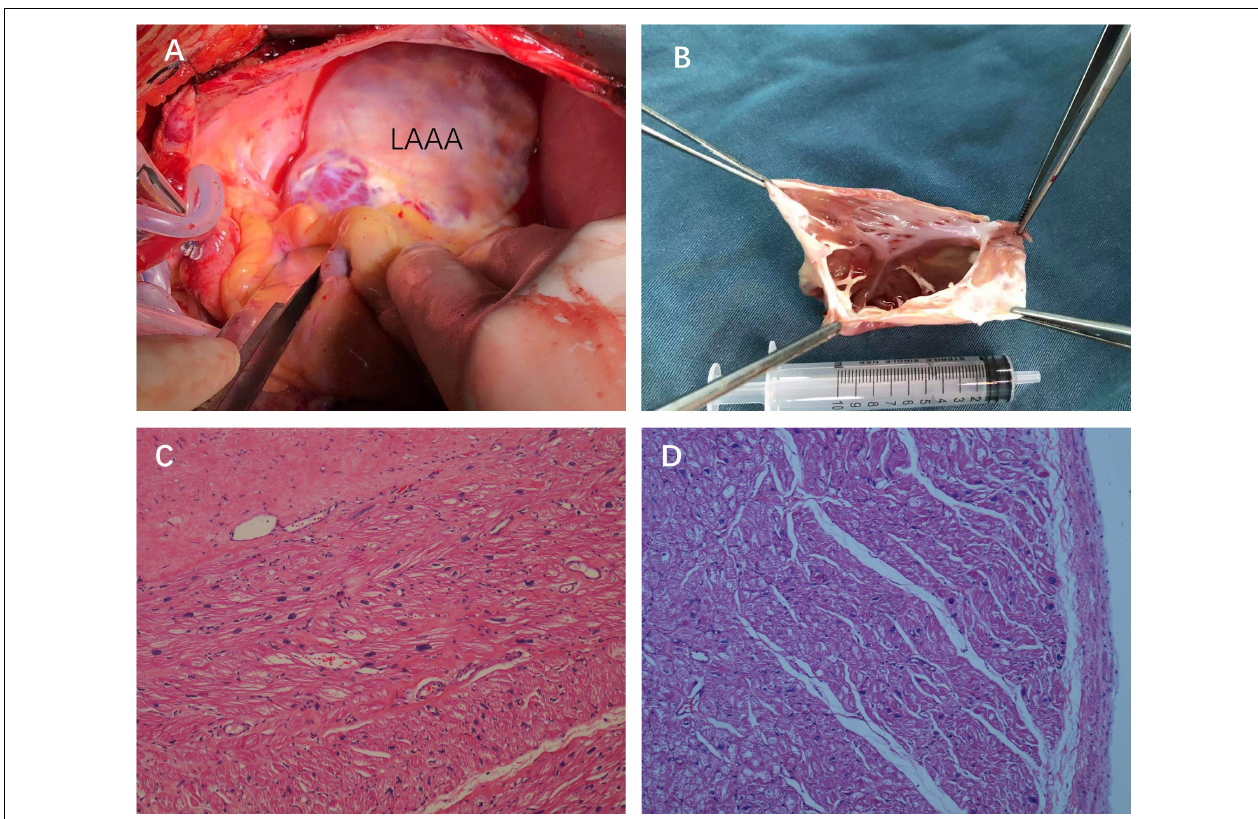
FIGURE 3 | Intraoperative views (A) and the surgical specimen of the LAAA with no thrombus inside the cavity of the aneurysm (B) . Hematoxylin and eosin staining of the resected left atrial appendage tissues showing the wall of the aneurysm composed of the myocardium and fibrotic tissue [ (C,D) , 2007 ×